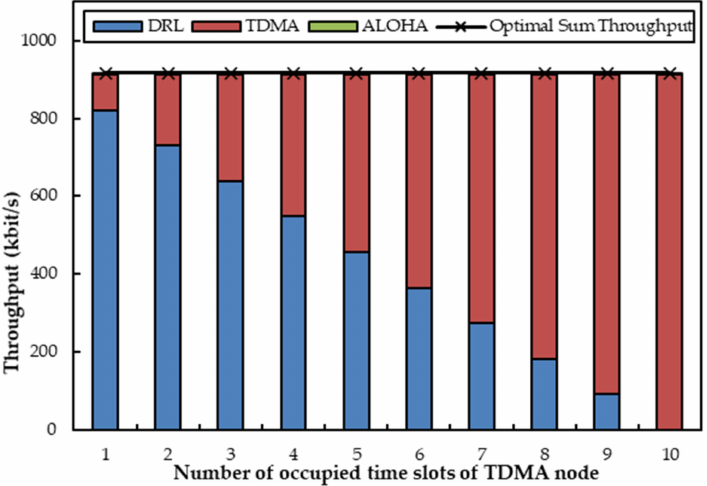
Figure 10. Sum throughput when one agent coexists with one acoustic ALOHA node and one optical TDMA node, which have fixed q and variable R